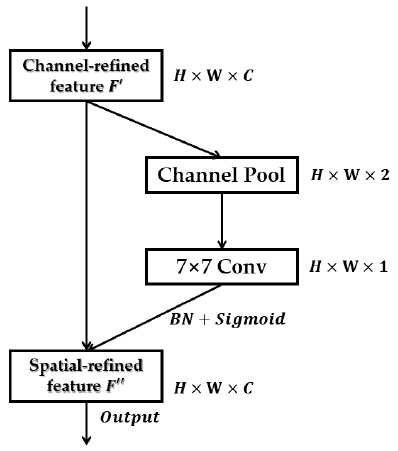
Figure 5. The spatial attention module of the LRCA-Net.